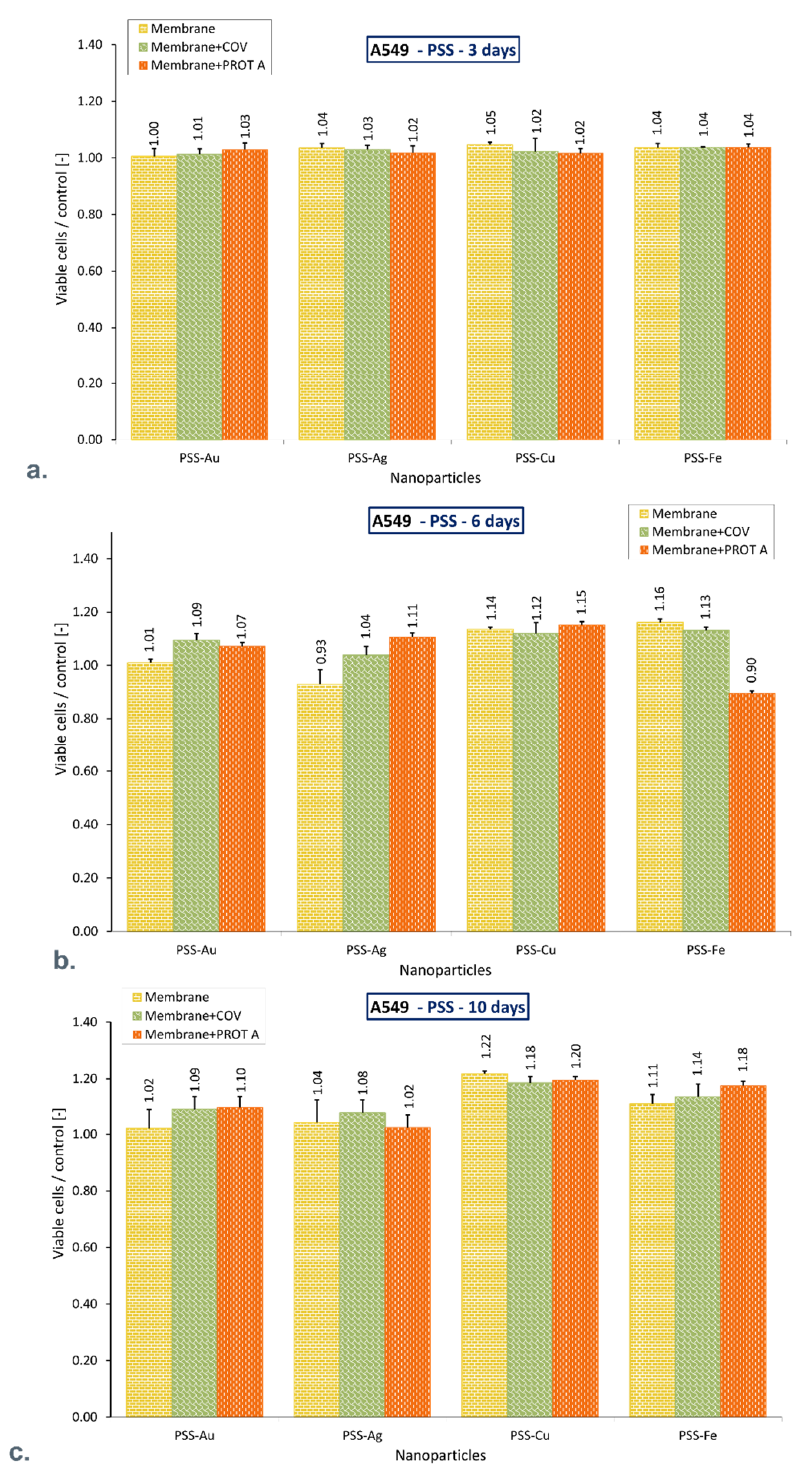
Figure 3. The ratio of the percentage of viable A549 immobilized on membranes to the control after ( a ). 3-day culture, ( b ). 6-day culture, ( c ). 10-day culture. The values are presented as mean ± SD. Key to the symbols: polystyrene sulfonate membrane with AuNPs incorporated (PSS-Au), polystyrene sulfonate membrane with AgNPs incorporated (PSS-Ag), polystyrene sulfonate membrane with CuNPs incorporated (PSS-Cu), polystyrene sulfonate membrane with FeNPs incorporated (PSS-Fe). Membrane—the membrane without adsorbed COV or PROT A; Membrane + COV—membrane with adsorbed COV; Membrane +PROT A—membrane with adsorbed Protein A.